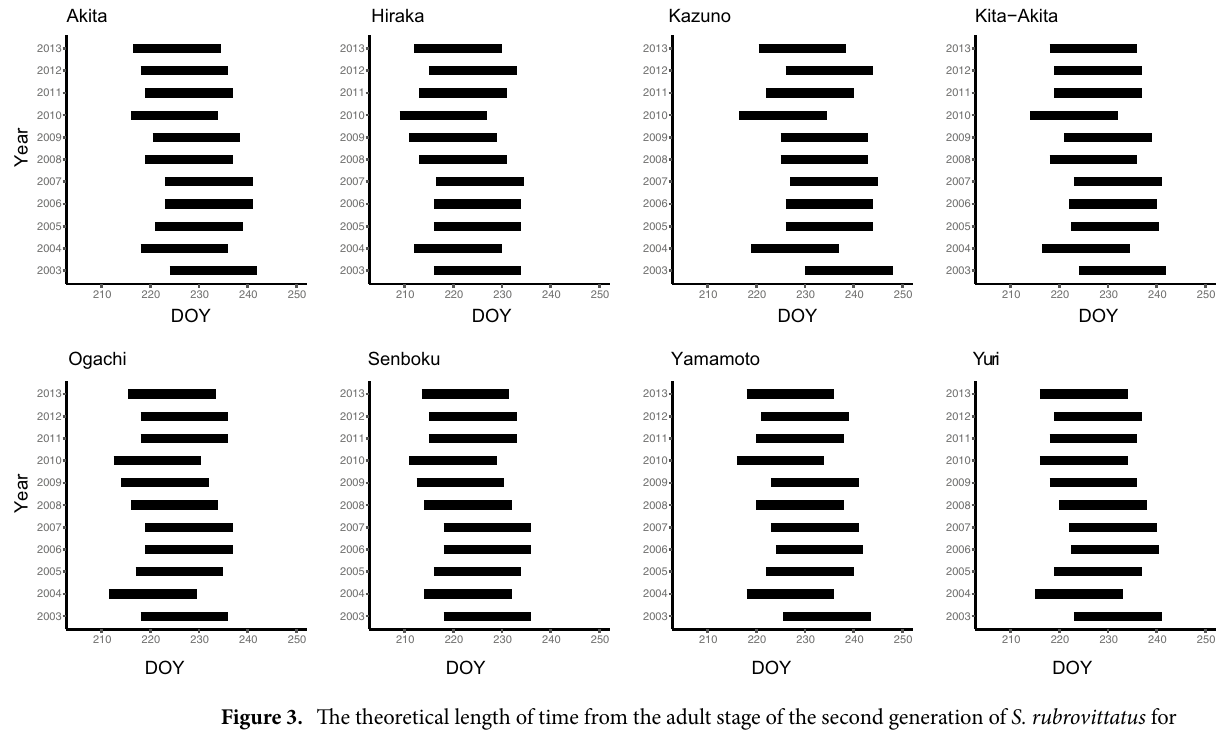
Figure 3. The theoretical length of time from the adult stage of the second generation of S. rubrovittatus for each year in each region. X axis indicates DOY means “Day of Year” which is continuous number from 1 (1, Jan) to 365 or 366 (31, Dec). The length of each bar indicates 18 days, the mean longevity of this species.